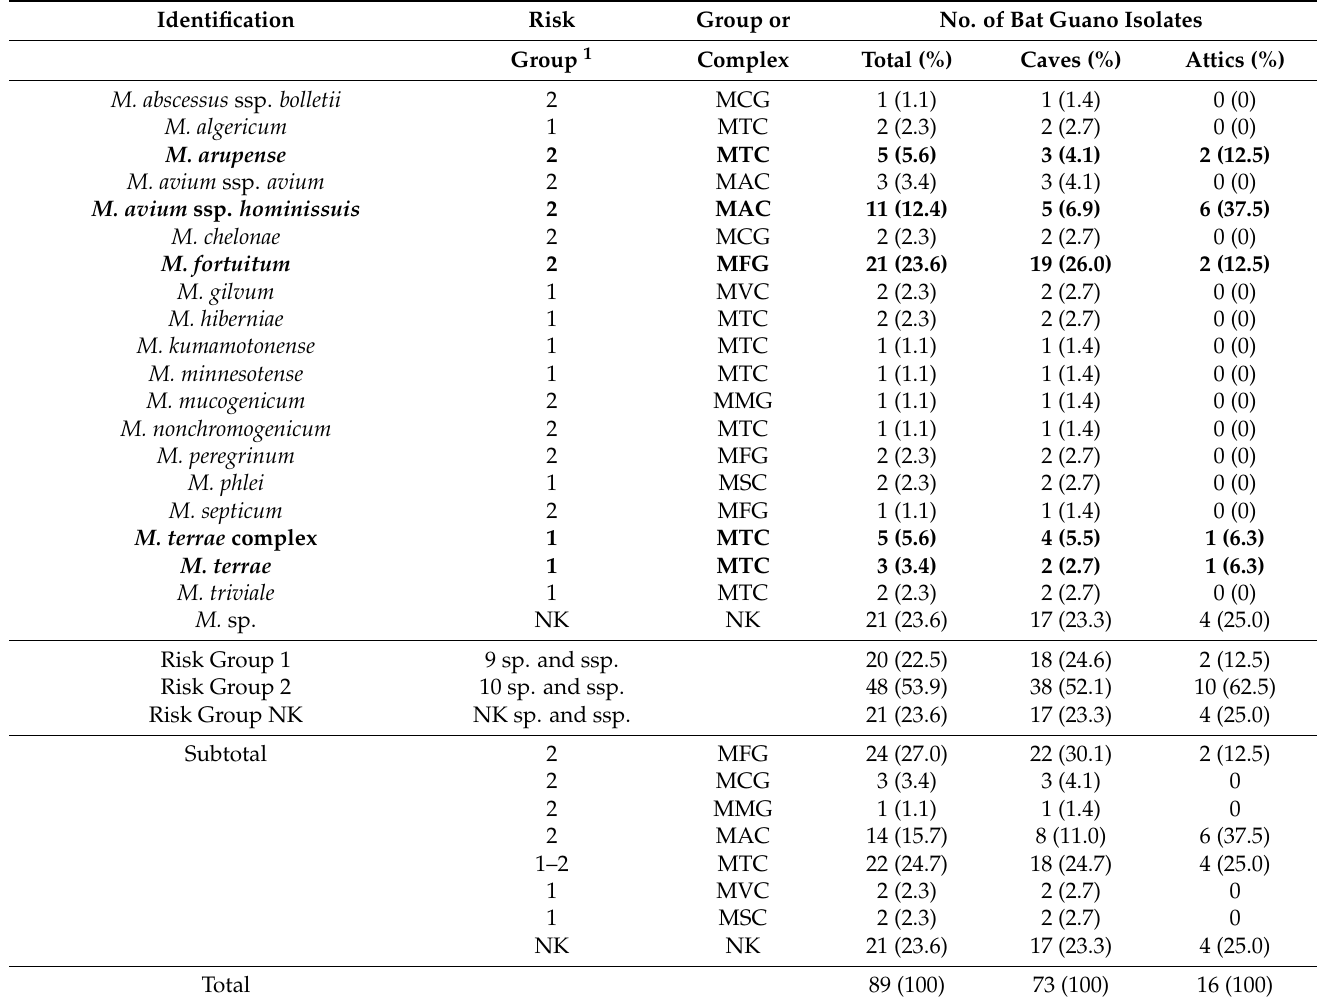
Table interpretation. M. = Mycobacterium ; sp. = species; ssp. = subspecies; MFG = M. fortuitum Group; MCG = M. chelonae Group; MMG = M. mucogenicum Group; MAC = M. avium Complex; MTC = M. terrae Complex; MVC = M. vaccae Complex; MSC = M. smegmatis Complex; NK = Not Known Mycobacterium sp.; in bold are sp., ssp. and complex isolated from both bat guano types (from caves and attics); NK = not known; 1 Directive 2000/54/EC